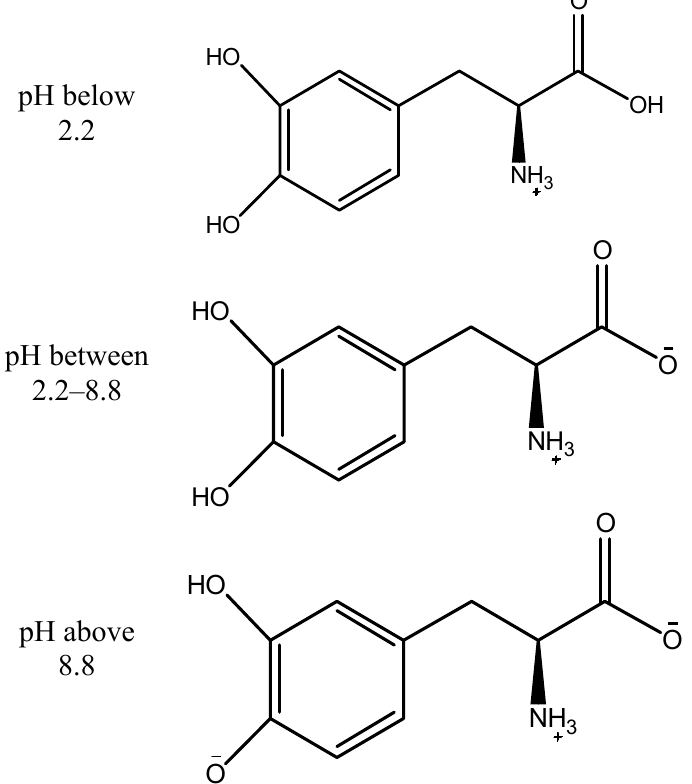
Figure 5. Structure of levodopa modification at different pH